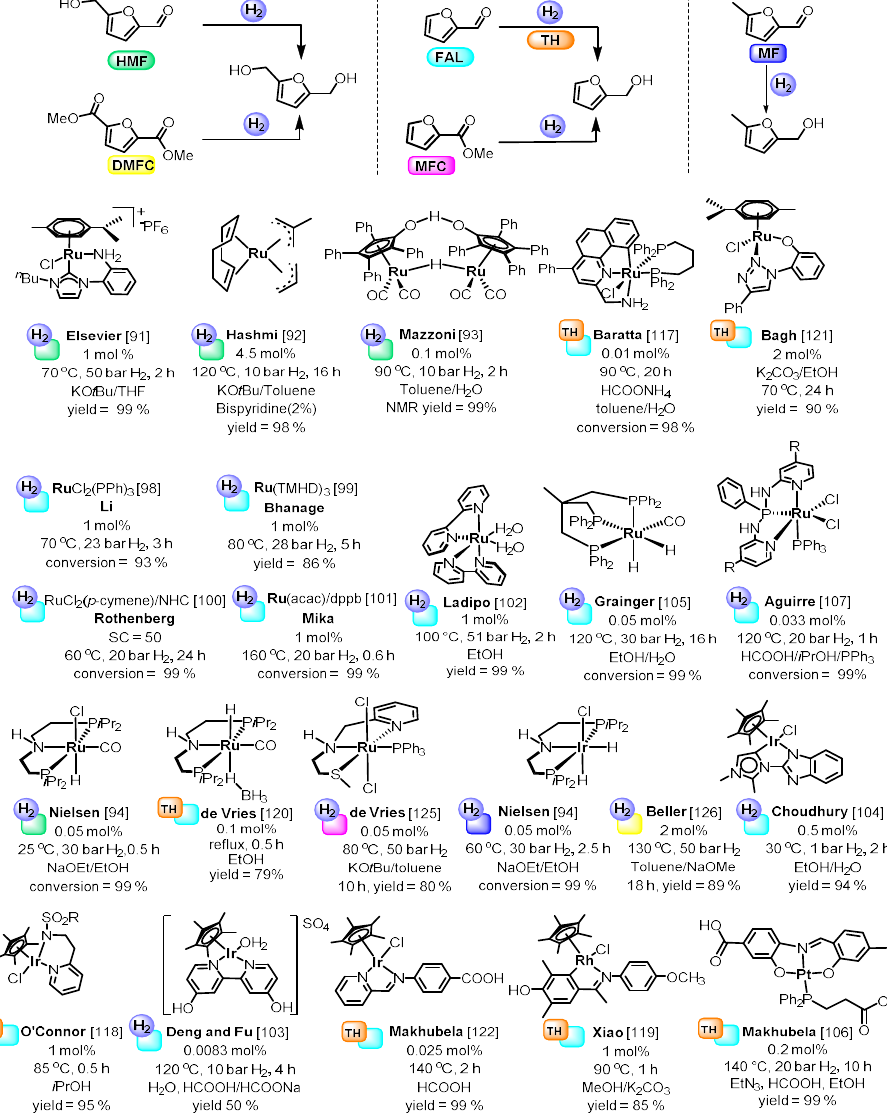
Figure 4. Well-defined precious-metal complexes for the selective hydrogenation/transfer hydro- genation of furanic aldehydes and esters to alcohols.